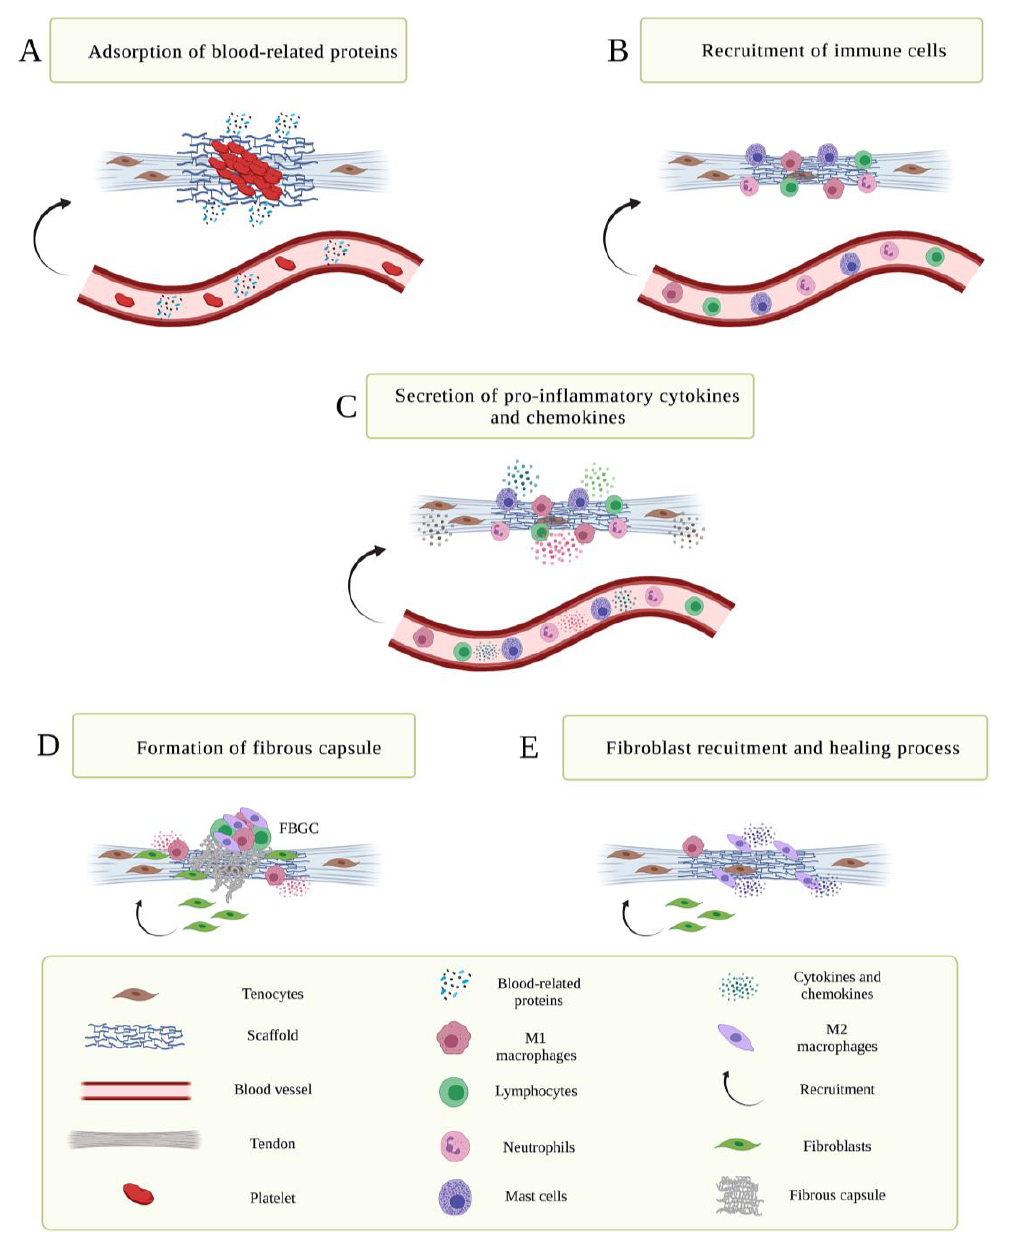
Figure 3. Interaction between scaffold and host tissue after implantation. The host starts a cascade of reaction called foreign body response (FBR). ( A ) Blood-related proteins and circulated platelets are recruited at the implantation site and are adsorbed on the surface of the scaffold allowing the activation of the coagulation process. ( B ) Immune cells are recruited at the implantation site and are accumulated between the scaffold and the surrounding tissue. ( C ) The immune cells start to secrete pro-inflammatory cytokines and promote inflammation. ( D) The protracted presence of the scaffold and the persistent inflammation accompanied with the increased number of M1 pro-inflammatory cytokines leads to a continuous activation of tenocytes which secrete more collagen, which contributes to the formation of fibrous capsule and the rejection of the scaffold. ( E ) The switch of macrophages towards the anti-inflammatory/pro-regenerative phenotype M2 promotes tendon regeneration and facilitates the healing process.